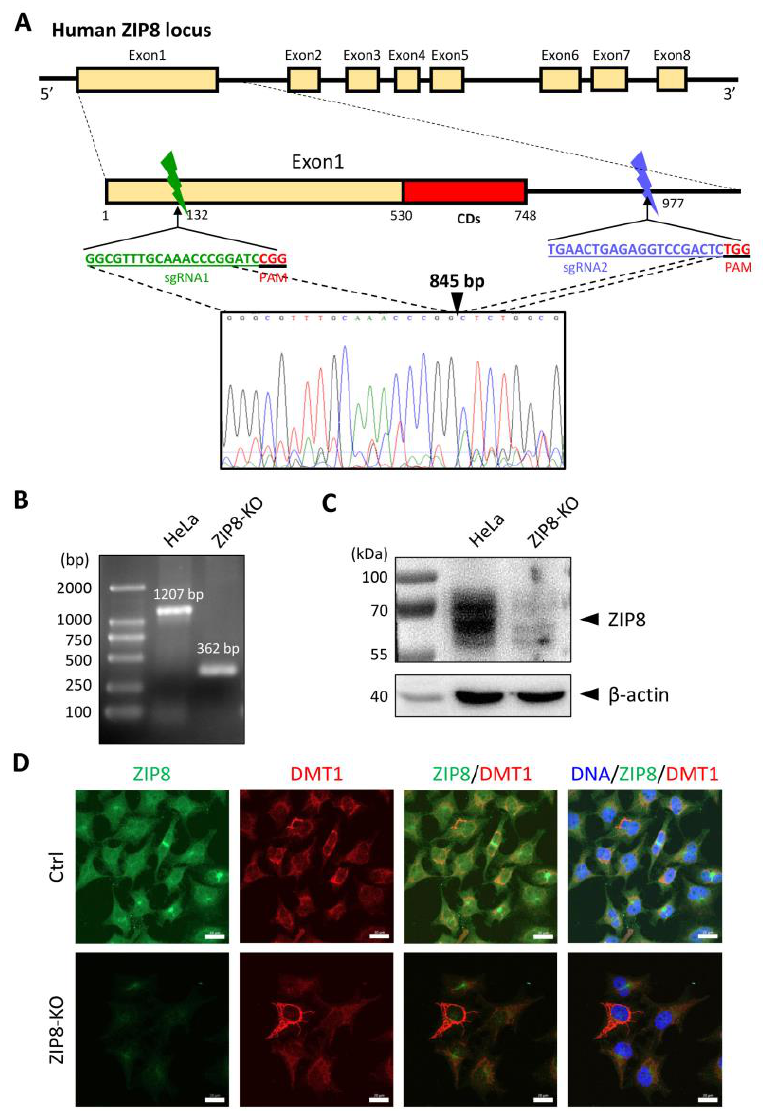
Figure 1. Generation of a ZIP8-KO HeLa cell line using the CRISPR/Cas9 genome editing technology. ( A ) Schematic of the CRISPR/Cas9 system to KO ZIP8. Two sgRNAs (green and blue bars) were designed to pair with the targeted DNA in order to delete a desire region in the human ZIP8 locus (part of exon1 and intron1). Each of the sgRNAs contains 20 bp single guide sequence followed by